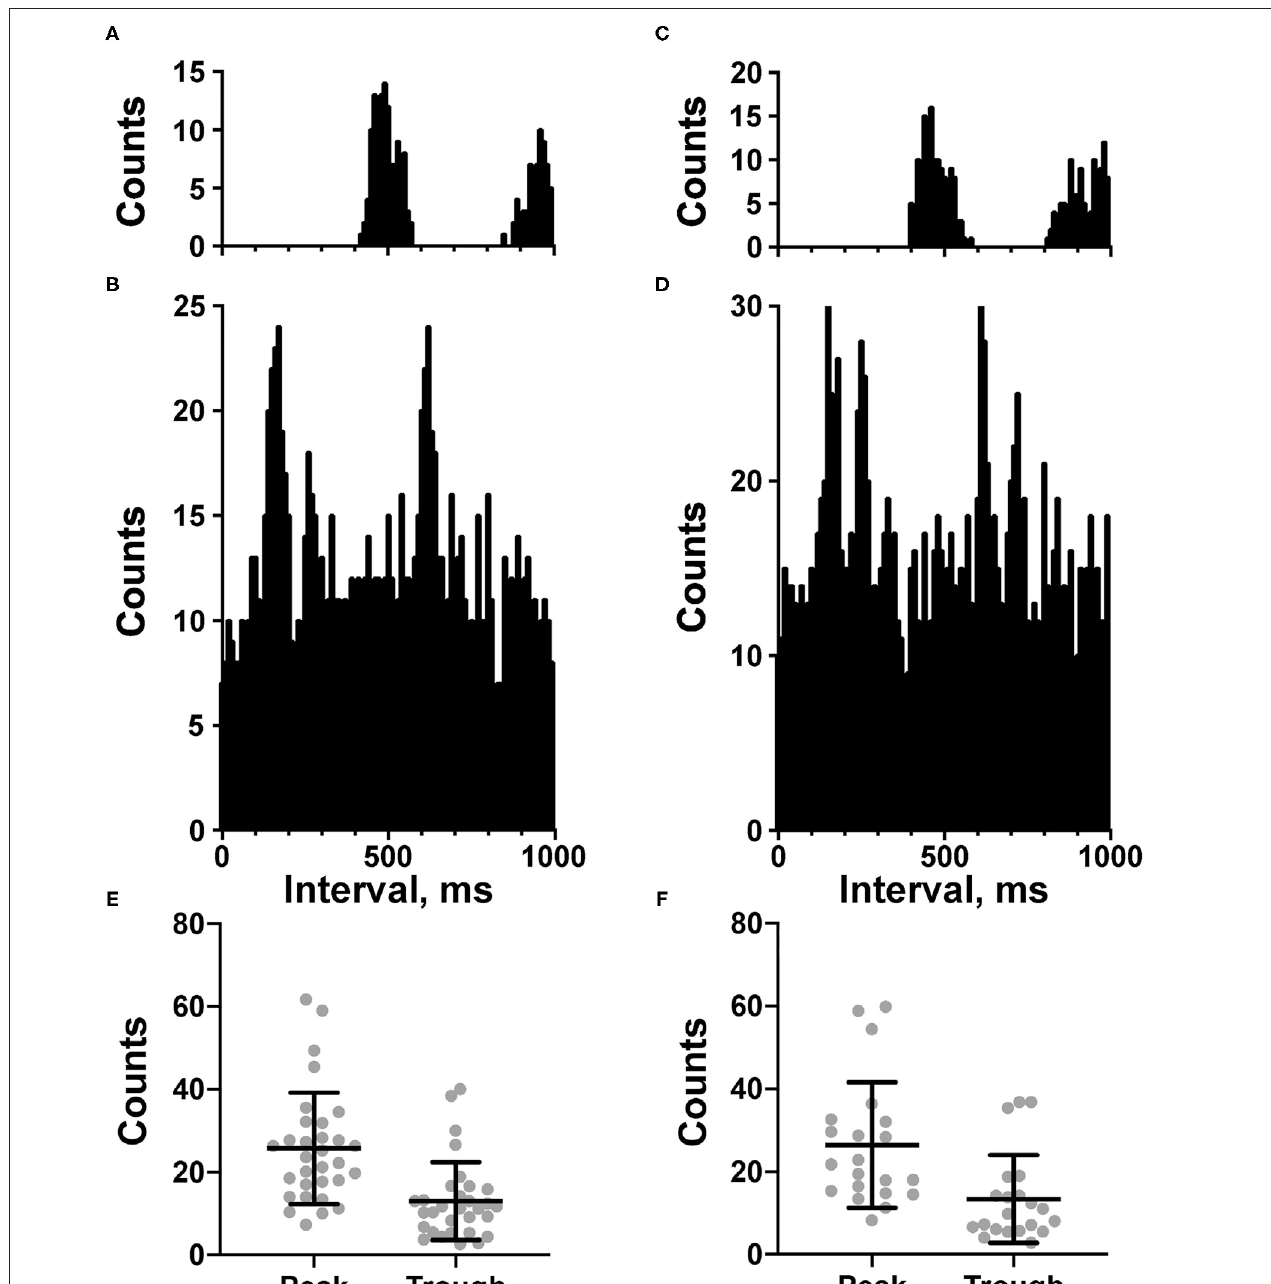
FIGURE 2 | (A–D) Cardiac-related activity (CRA) evident in two trials for an NTS neuron ( A,B are for one trial and C,D are for the second trial). Histograms were triggered by event markers demarking ECG R-waves; bin width is 10ms. (A,C) show intervals between R-waves, and (B,D) show intervals between the unit’s action potentials. Unit activity peaked in periods between R-waves. (E,F) plot of counts during peak and trough periods for the LTF (E) and NTS (F) neurons classified as exhibiting CRA.